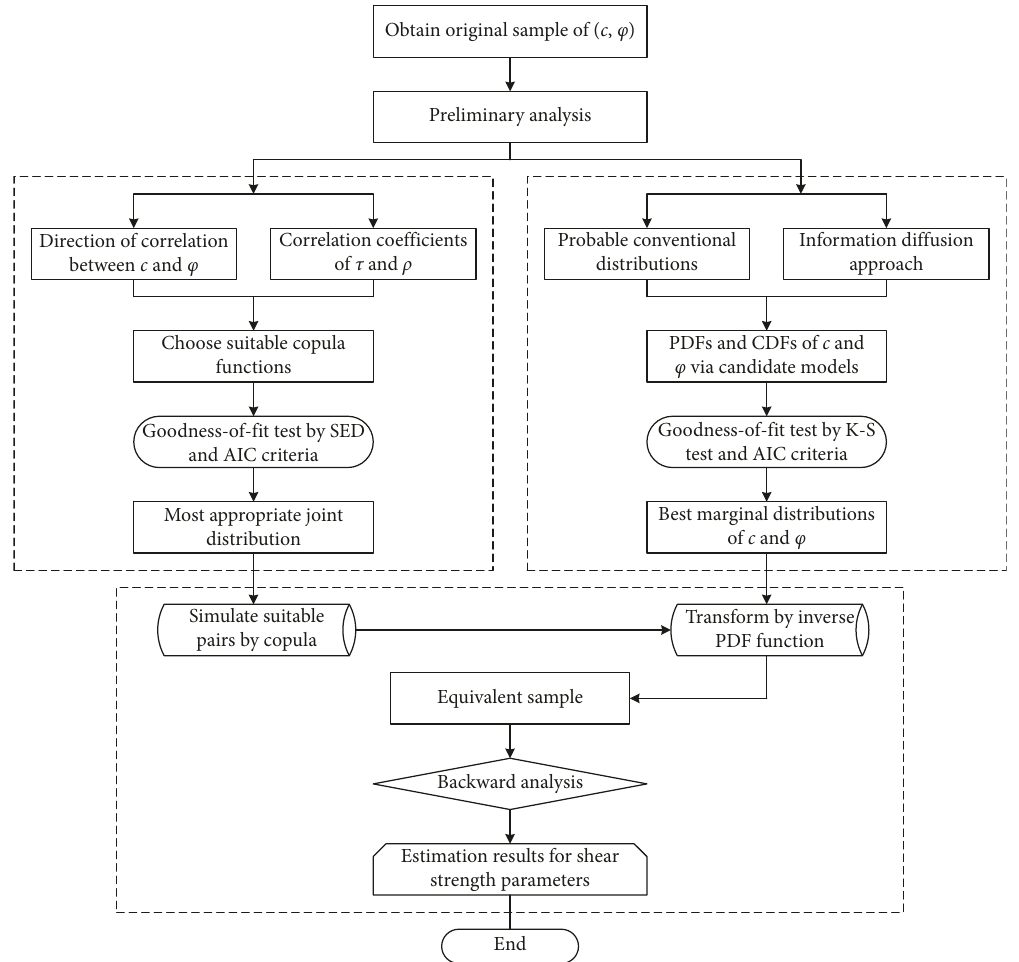
Figure 2: Flow diagram of optimal estimation model based on copula theory coupling information diffusion technique.